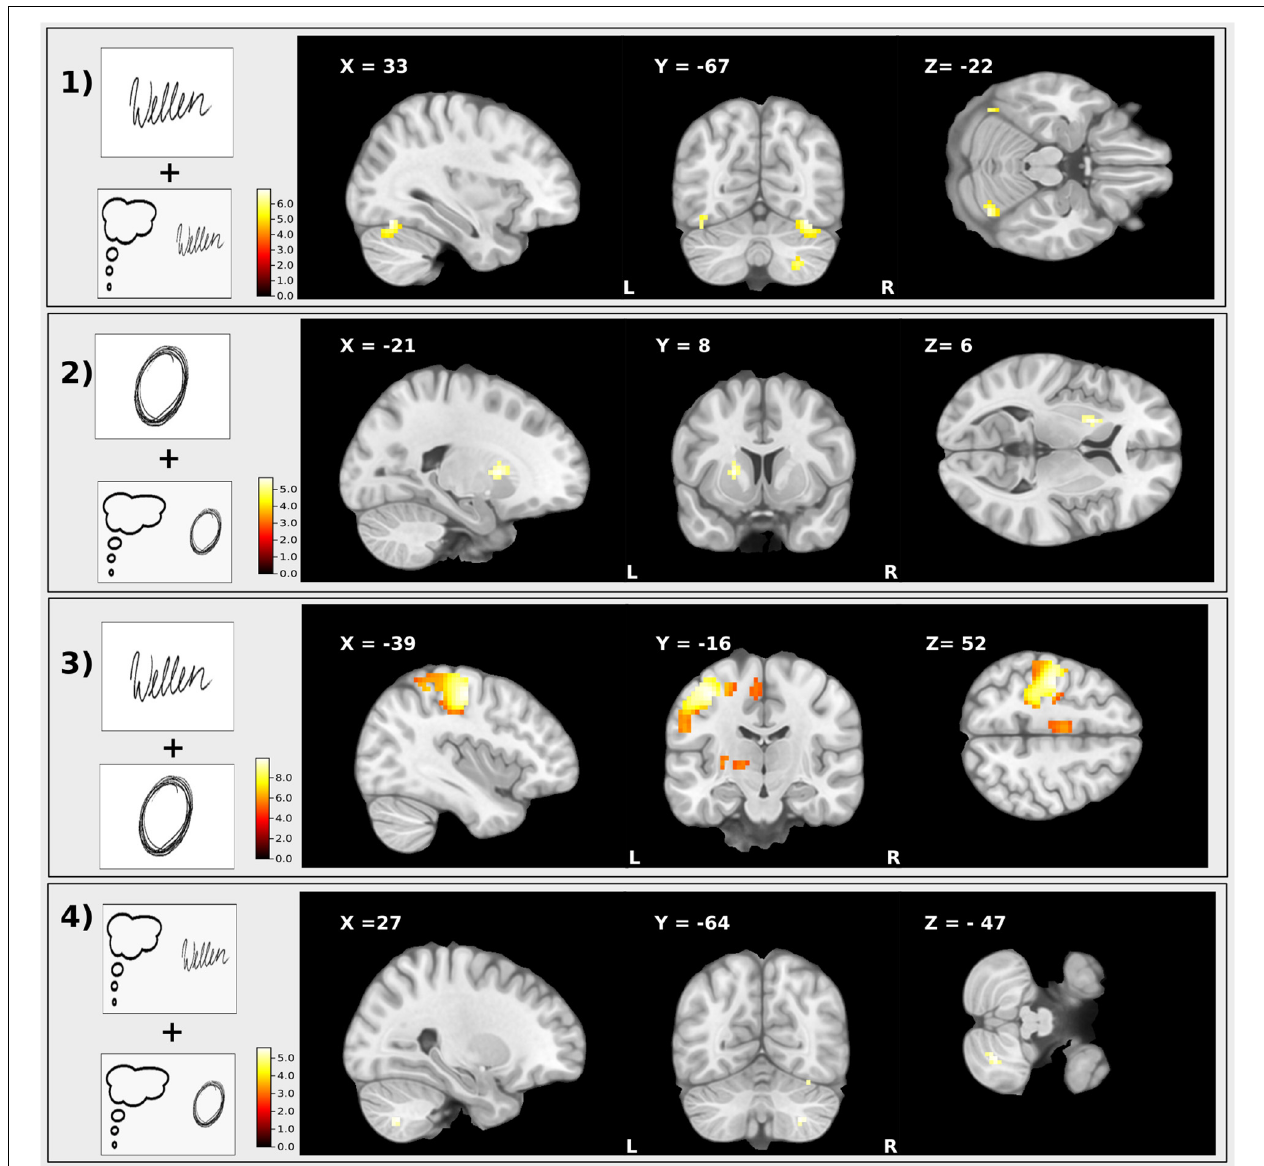
FIGURE 5 | T-maps of the results of the different conjunction contrasts. (1) Conjunction: Executed writing and imagined writing, (2) Executed drawing and imagined drawing, (3) Executed writing and drawing, (4) Imagined writing and drawing. Clusters are significant within the ROI analysis after FWE-correction on p <